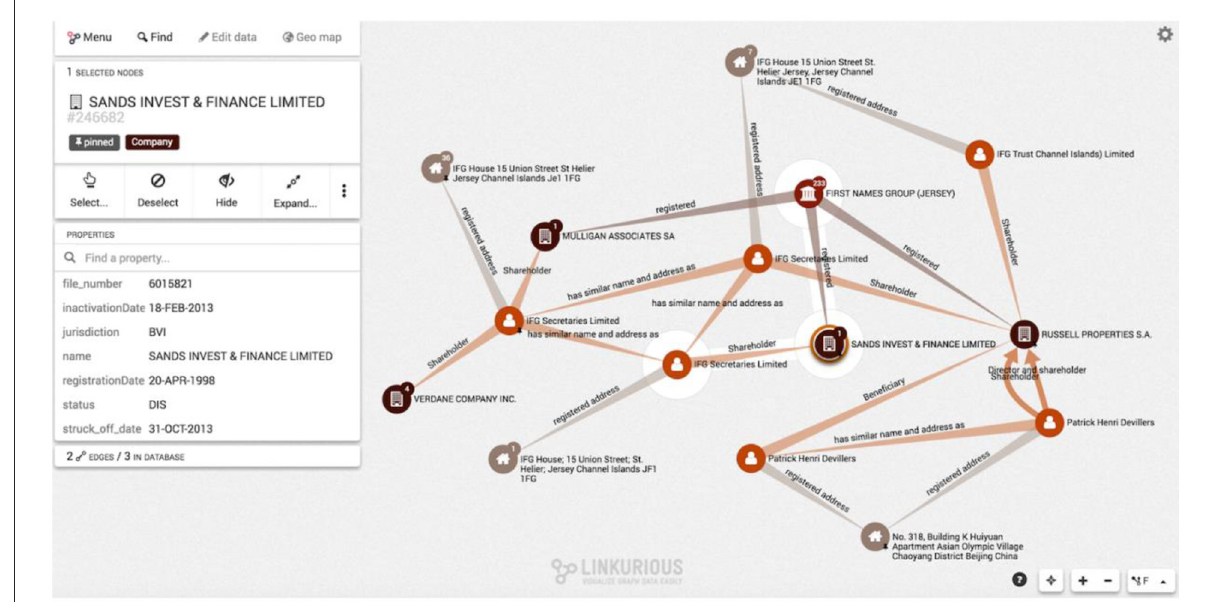
FIGURE1 Network visualization with Linkurious tool from 2015 Panama Papers project showing different kinds of legal and financial relations between companies, addresses and people associated with